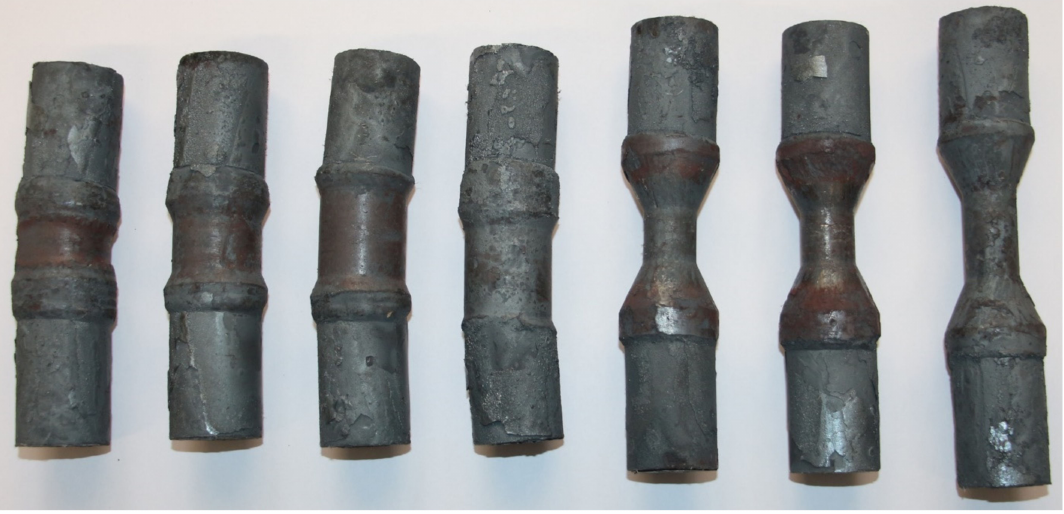
Figure 11. Workpieces after